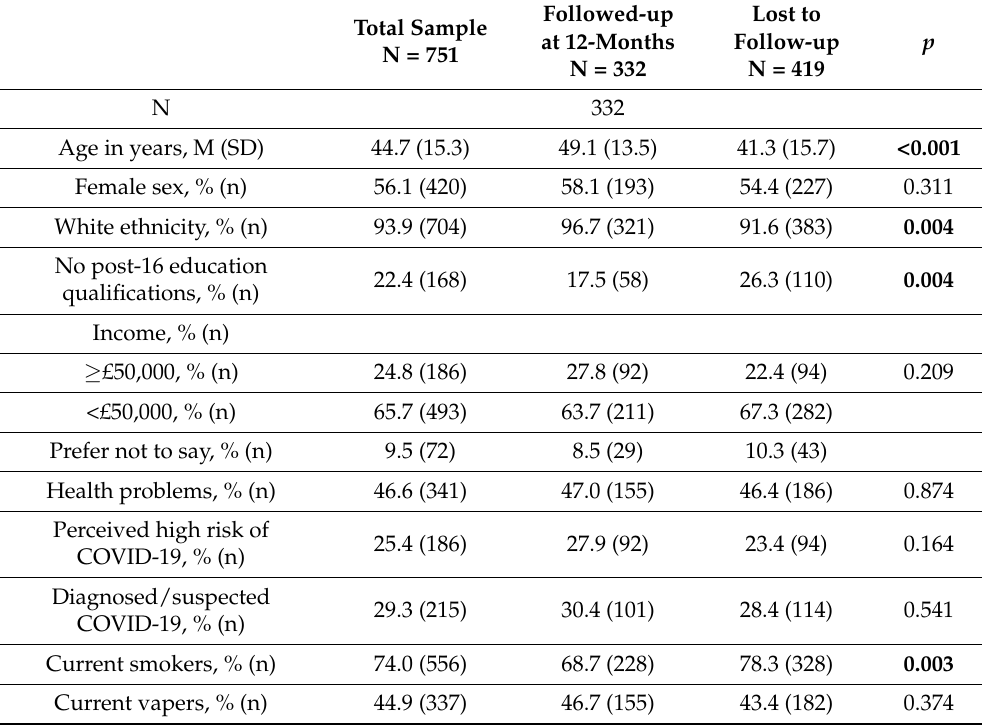
Table 1. Baseline sample characteristics of total, followed-up at 12-months, and lost to follow- up samples. Lost to Followed-up Total Sample p Follow-up at 12-Months N = 751 N = 419 N = 332 N 332 Age in years, M (SD) 44.7 (15.3) 49.1 (13.5) 41.3 (15.7) <0.001 Female sex, % (n) 56.1 (420) 58.1 (193) 54.4